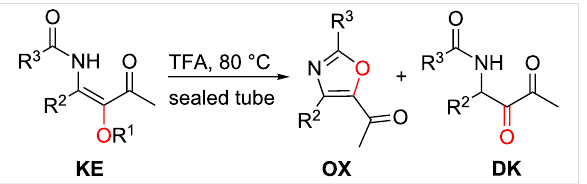
Table 6: Preparation of oxazoles OX1 – 15 and 1,2-diketones DK1 – 13 through trifluoroacetic acid-promoted reaction of β -ketoenamides KE . a